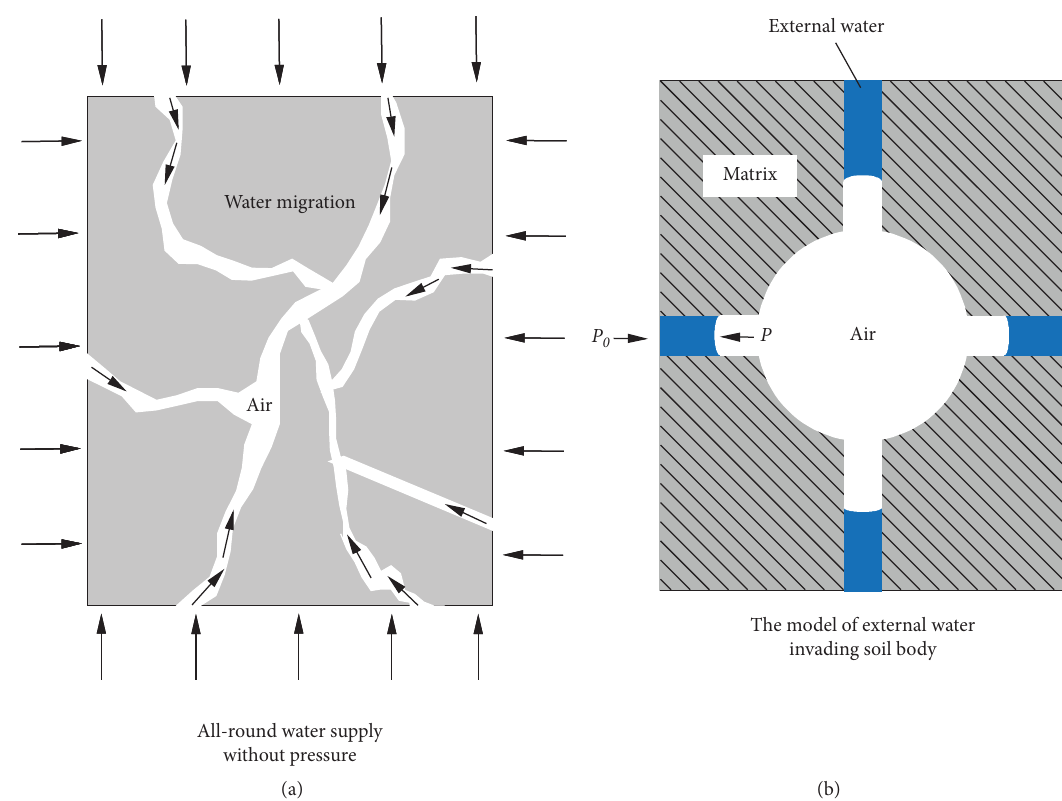
Figure 8: Sketch of water migration and the simplified model of Test